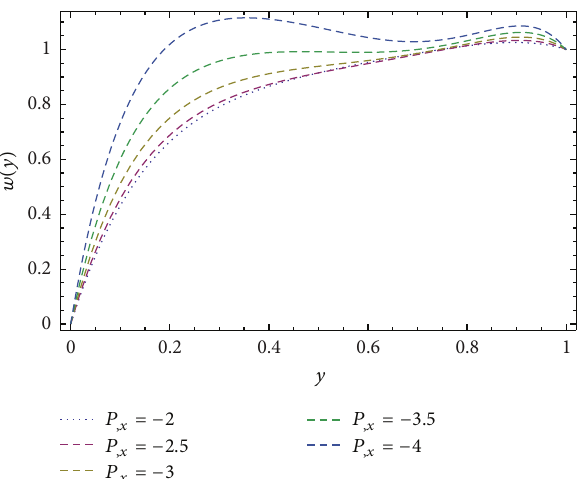
Figure 5: Profile of the nondimensional velocity 𝑢(𝑦) for different ̃𝛽 = 0.3 , 𝑃 ,𝑧 = −2.0 , and 𝜙 = 45 ∘ . values of 𝑃 ,𝑥 , keeping